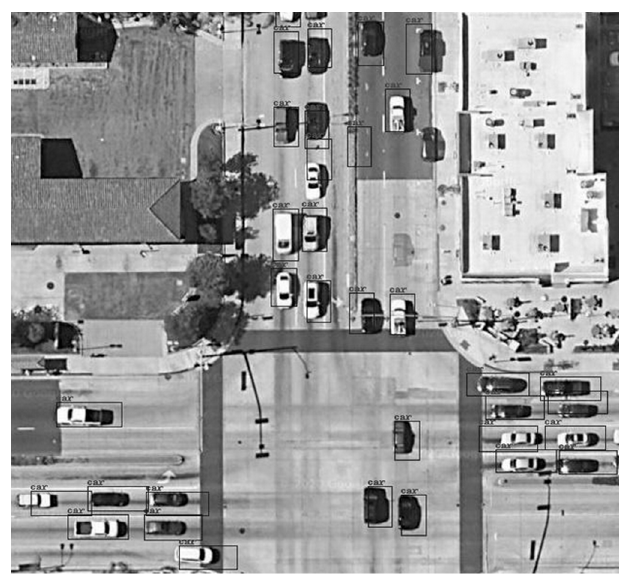
Figure 21. The detection result of Los Angeles.